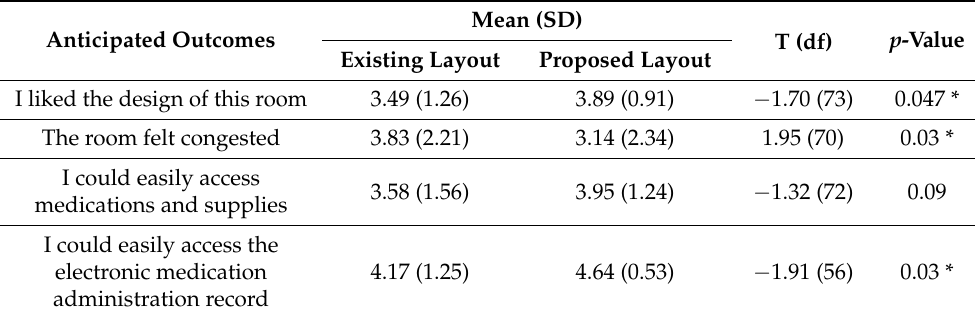
Table 6. Comparison of survey responses from scenario enactment participants between the existing and proposed